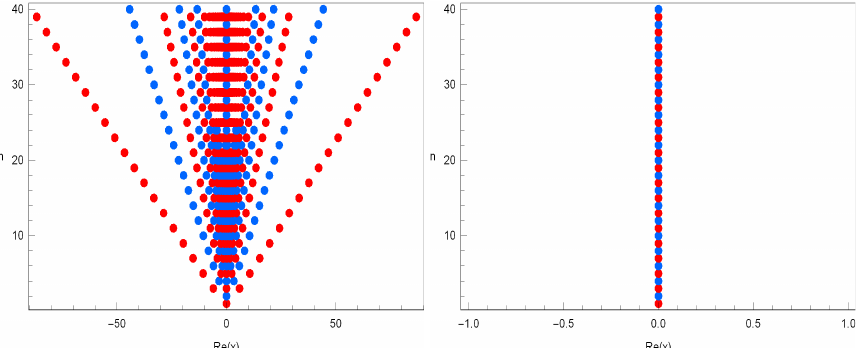
Figure 6. Real zeros of E